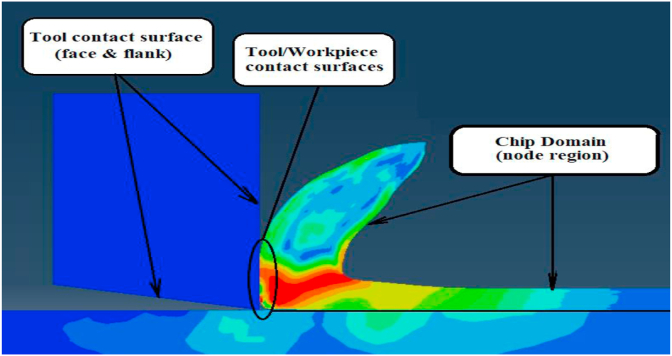
Model contact pairs.